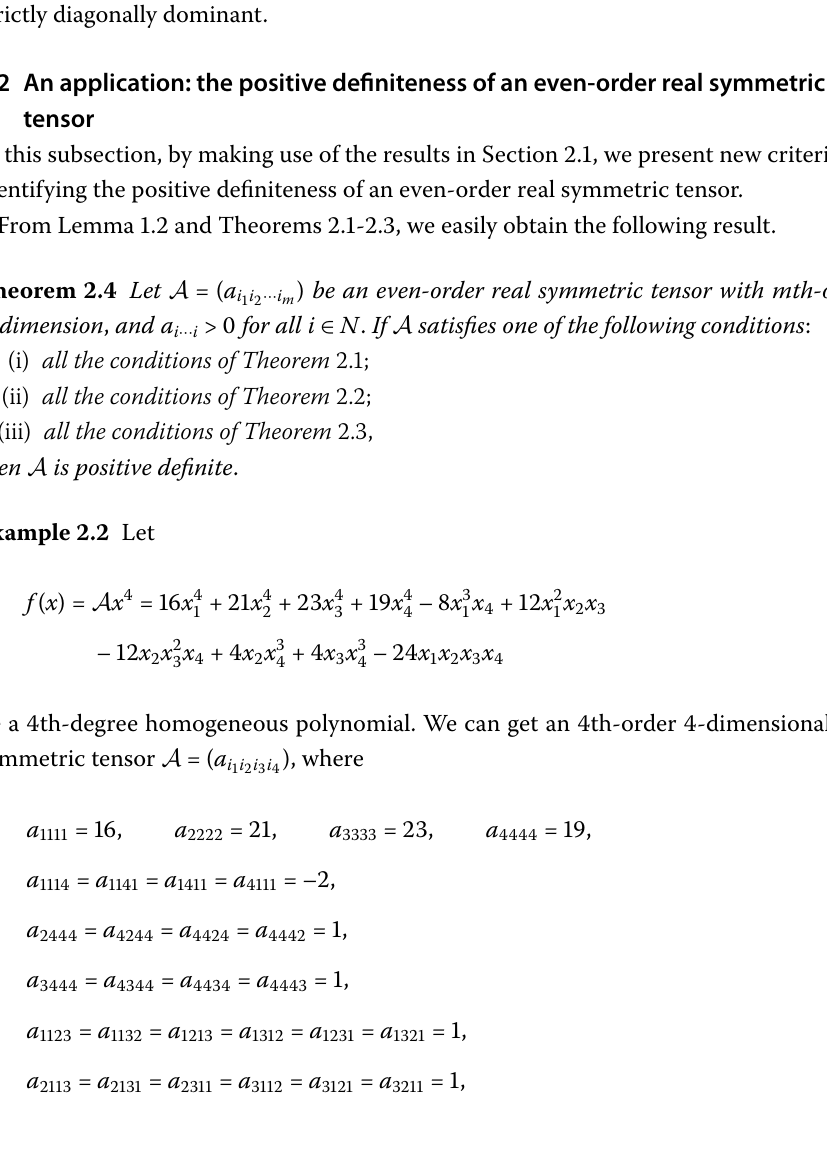
Table 1 The results of R ( l +1)